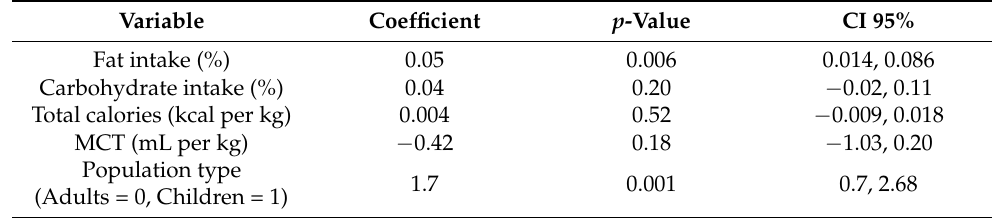
Table 3. Mixed-model multivariate analysis, covariates associated with blood ketone